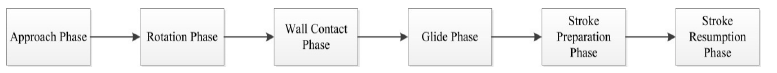
Figure 24. The acceleration signals from a back worn sensor device can be used to identify different phases (block, flight, glide, swim) of starts. Additional video input is necessary to determine the end of the start phase at 15 m. Reproduced with permissions from Le Sage, Bindel, Conway, Justham, Slawson, Webster and West